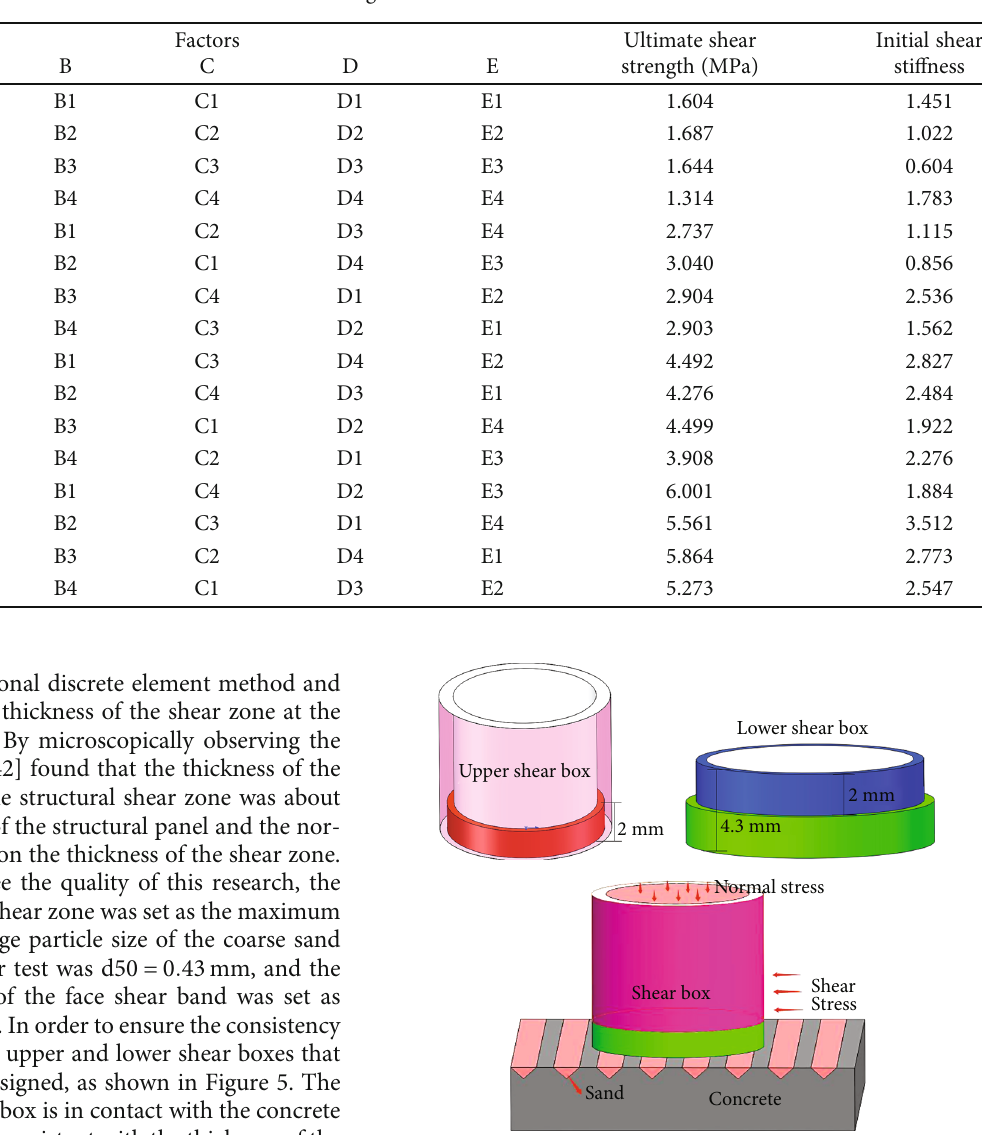
Table 5: Ultimate shear strength and initial shear sti ff ness.